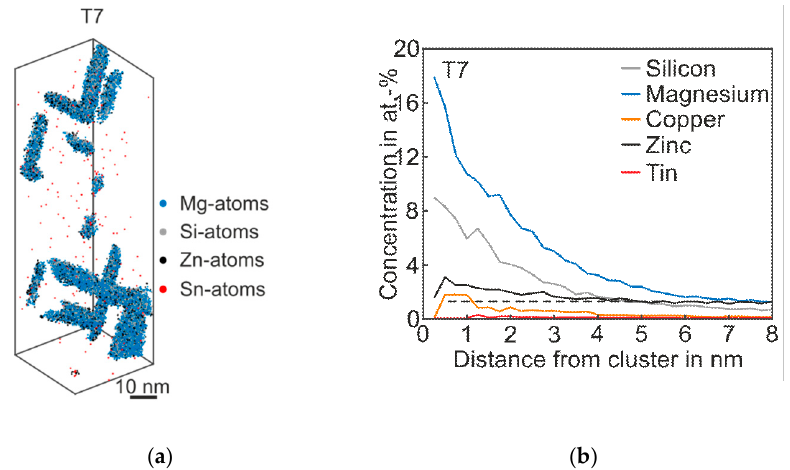
Figure 6 . APT analyses of Alloy Zn + Sn visualizing the 3D atom maps of Mg–Si co-clusters ( a ) in T7 condition. The corresponding proxigram is presented in ( b ). The dotted line indicates the matrix concentration level of Zn.